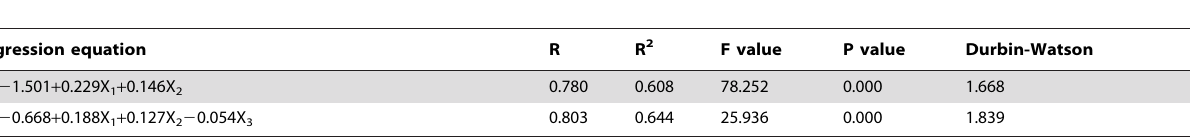
Table 3. Linear regression model of natural logarithm of annual incidence of HFRS and related factors in cities of Hebei province from 1999 to 2011.